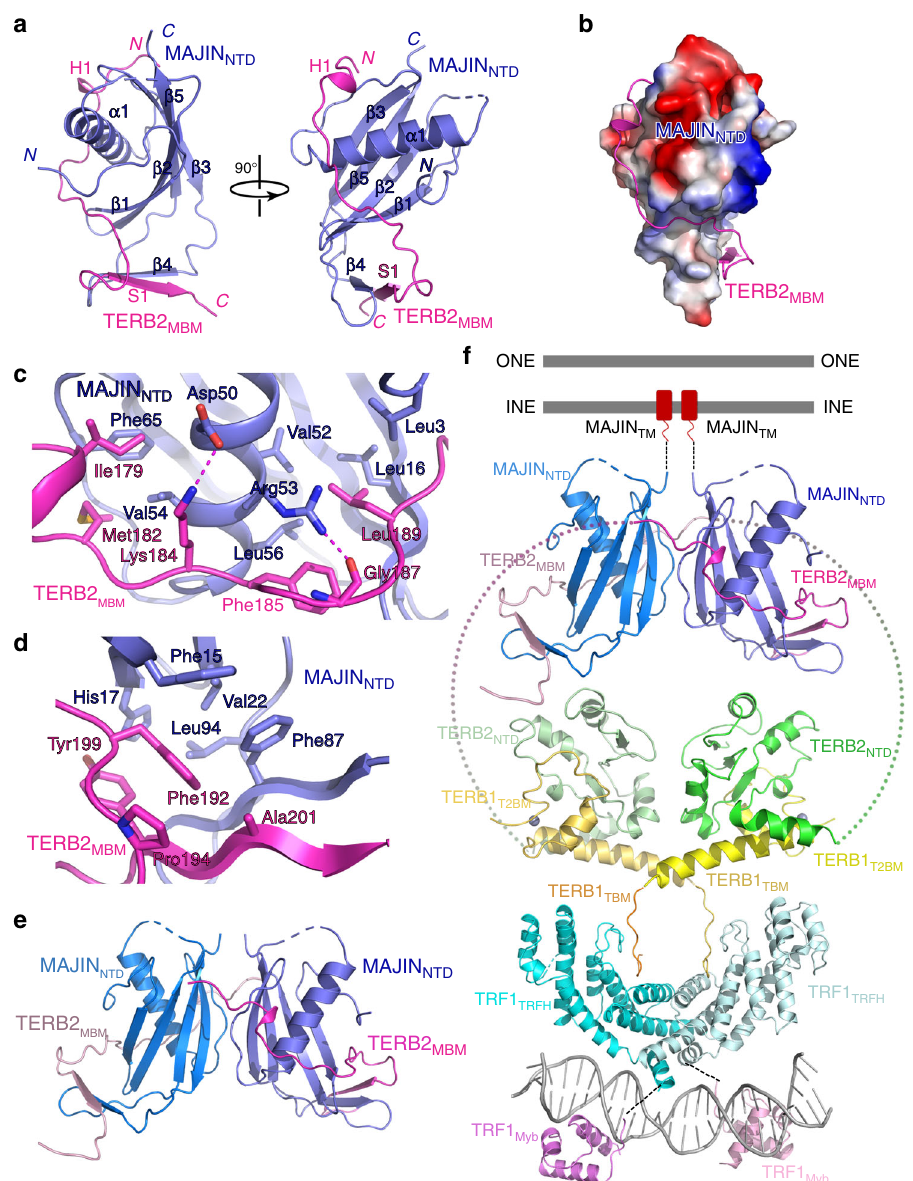
Fig. 3 Crystal structure of the TERB2 MBM – MAJIN NTD complex. a Ribbon diagrams of two orthogonal views of the TERB2 MBM – MAJIN NTD complex. TERB2 MBM is colored in magenta and MAJIN NTD in blue. b Electrostatic surface potential of TERB2 MBM -binding site of MAJIN NTD . Positive potential, blue; negative potential, red. c , d Detailed interactions at the TERB2 MBM – MAJIN NTD interface. The color scheme is the same as in a . Residues important for the interaction are shown in stick models. Salt bridges and hydrogen-bonding interactions are shown as magenta dashed lines. e Ribbon diagram shows the potential heterotetramer mode of the TERB2 MBM – MAJIN NTD complex revealed in the crystal structure. f Structural model of the connection between telomeres and the NE through the TRF1 – TERB1 – TERB2 – MAJIN interaction